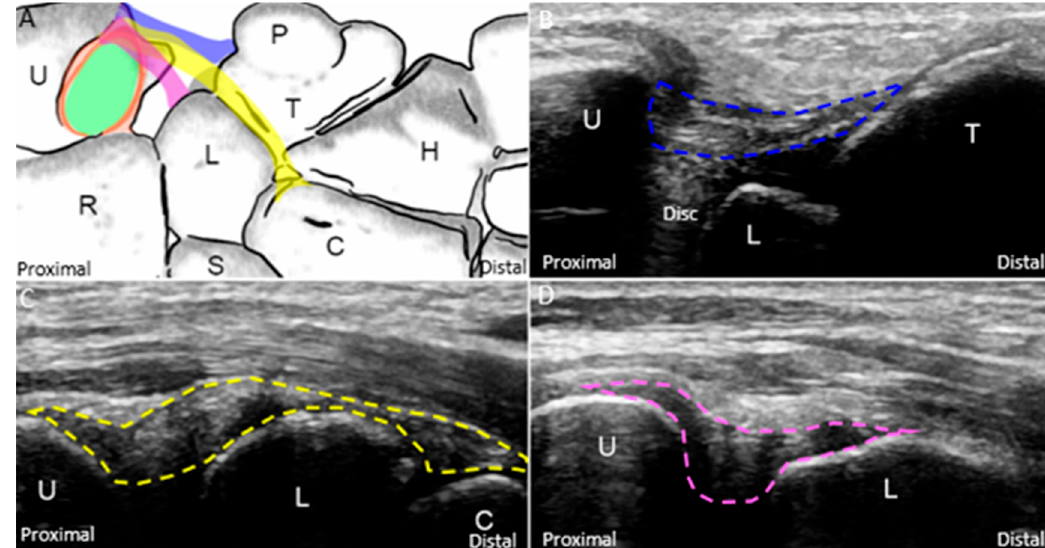
Figure 5. ( A ) The schematic drawing illustrates the ulnotriquetral (blue band) , ulnocapitate (yellow band) , and ulnolunate (purple band) ligaments. US imaging of the ( B ) ulnotriquetral (blue dashed line) , ( C ) ulnocapitate (yellow dashed line) , and ( D ) ulnolunate (purple dashed line) ligaments. US: ultrasound; U: ulna; R: radius; L: lunate; T: triquetrum; P: pisiform; H: hamate; C: capitate; S: scaphoid.